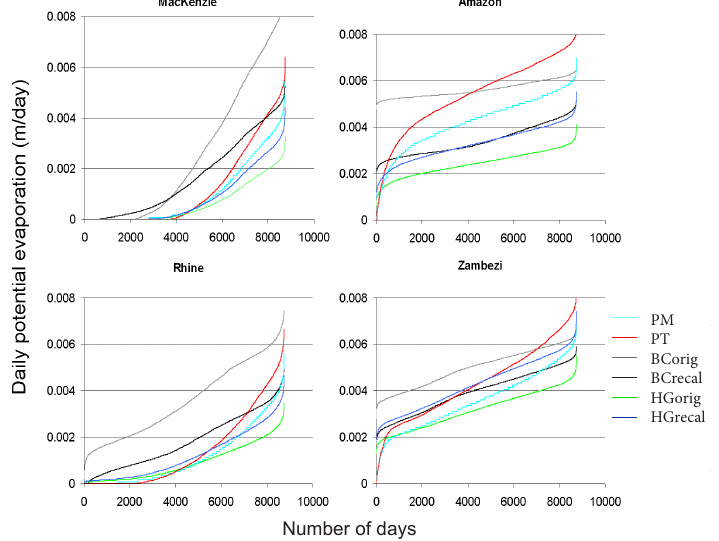
Fig. 5. CDFs of daily potential evaporation (mday − 1 ) for a selection of catchments; MacKenzie, Amazon, Rhine and Zambezi.